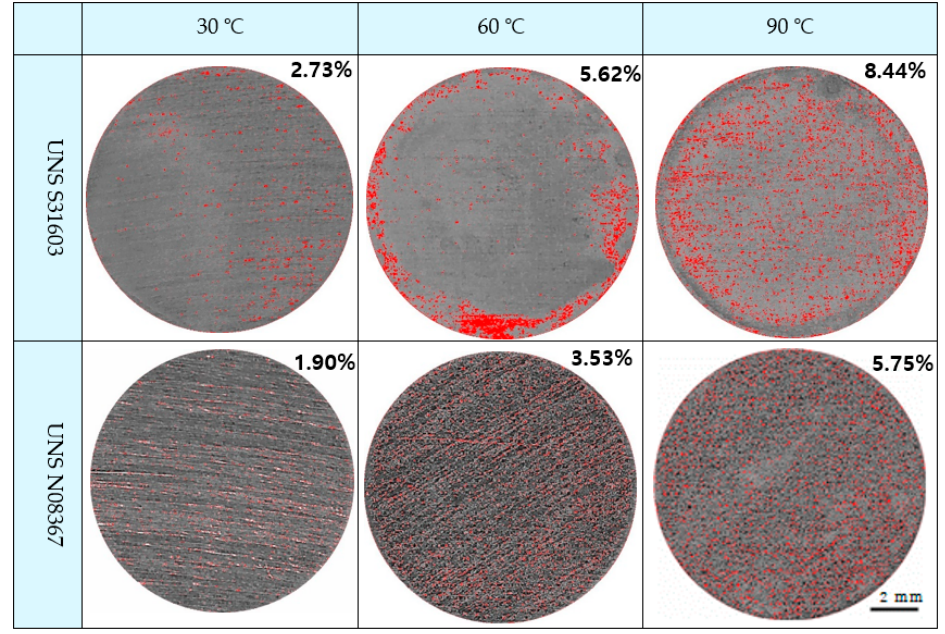
Figure 6. Appearance and corrosion area ratios of UNS S31603 and UNS N08367 after the electro- chemical experiments in a modified green death solution with temperatures.